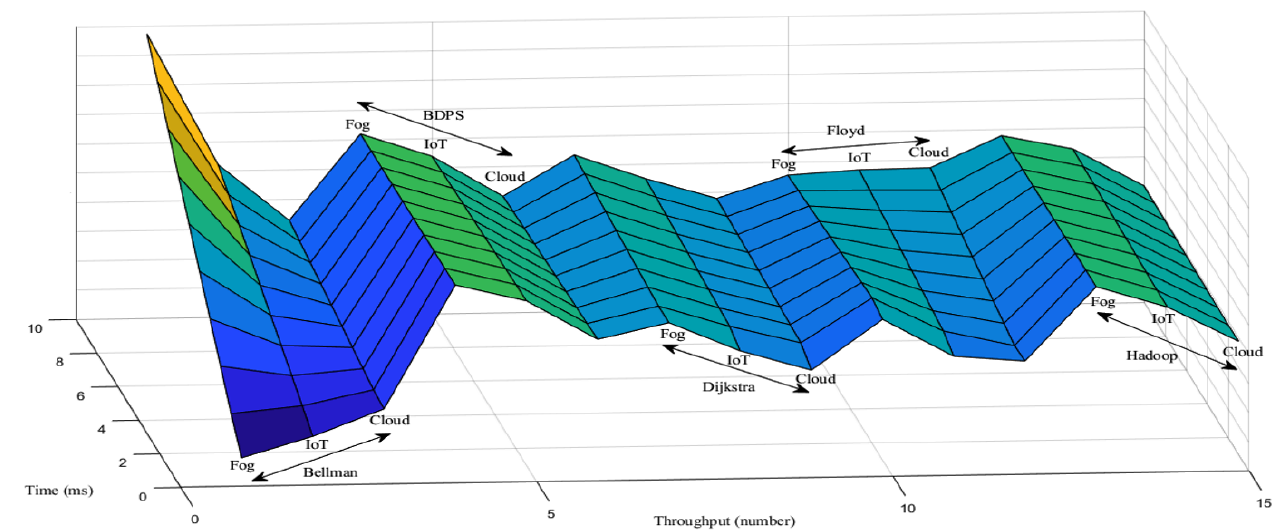
Figure 5. Throughput of data execution among existing algorithms and BDPS over fog-IoT mesh